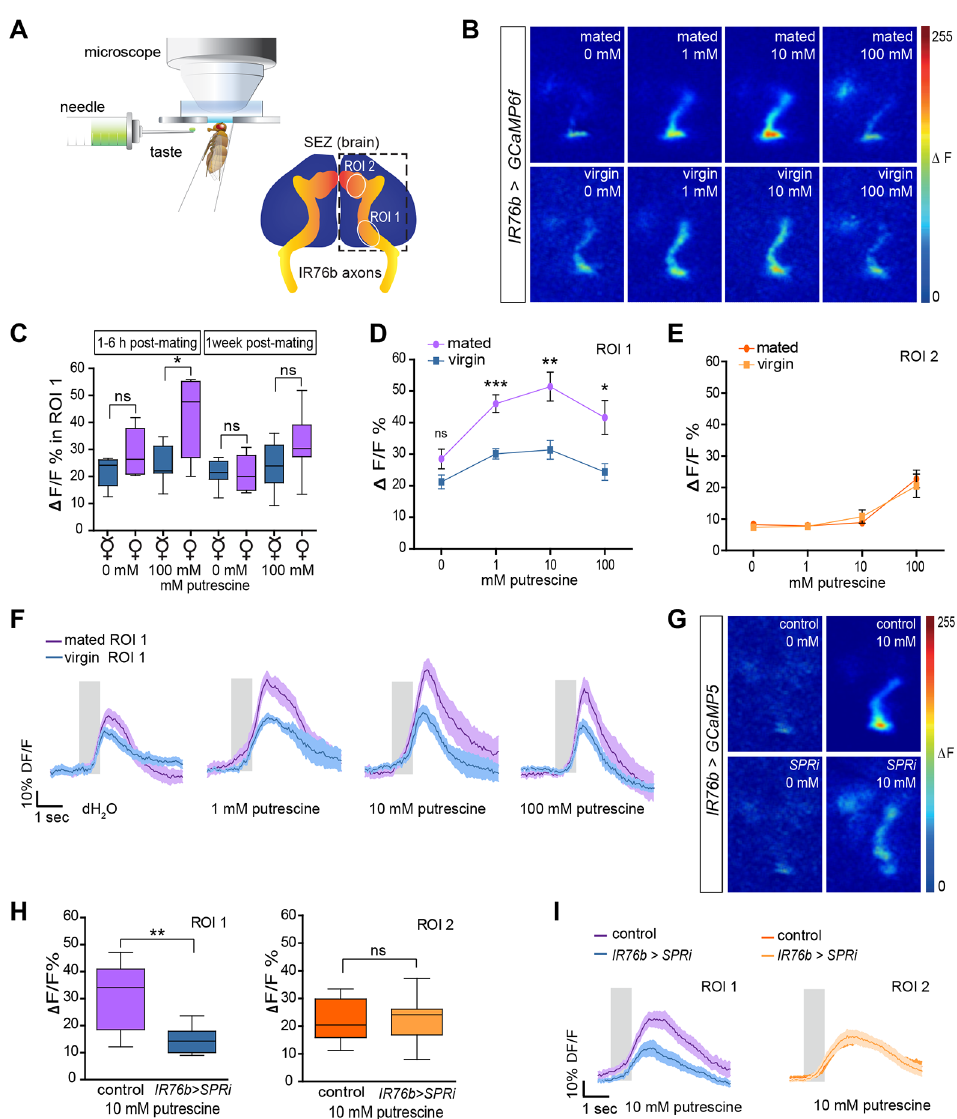
Fig 3. Mating increases sensitivity of taste neurons through SPR. (A) Scheme ofthe SEZ in vivo calcium imagingsetup (top). Illustration of theSEZ area showing the innervation pattern ofIR76b taste neuronaxons (bottom). ROI 1 and ROI 2 delineate theregions ofinterest (ROI) used for quantification ofthe relative change in GCaMP-fluorescence (% Δ F/F). (B) Representative images of SEZ imaging of IR76b-Gal4; UAS-GCaMP6f mated and virginfemaleflies stimulated with distilled water (0 mM), 1 mM putrescine (1 mM), 10 mM putrescine (10 mM), and 100 mM putrescine (100 mM), respectively. (C) IR76btaste neuron terminals of mated females show a significantly increased response to putrescineafter mating. While theresponse is highly significant at 1 – 6 h post- mating, it remains only a trend at 1 wk post-mating ( n = 7). (D) Females at 1 – 6 h post-mating showhigher IR76b taste neuronresponses. GCaMP6f-fluorescence peak responses were quantified (in% Δ F/F) in the ROI 1 area. Flies were stimulated with increasing concentrations of putrescine ( n = 7).(E) IR76btaste neurons of the same females as in(D) show no difference in the ROI 2 area. (F) Averageresponse trace of theROI 1 area ( n = 7). The gray bar illustrates the stimulation period. The dark colored linein themiddlepresents theaverage value, andthe light shade presents the SEM. (G) Representative images of IR76bGRN axons in theSEZ oftest ( IR76b-Gal4 , UAS-SPRi;UAS-GCaMP5 ) and control ( IR76b-Gal4;UAS-GCaMP5 ) females at 1 – 6 h post-mating.Flies were stimulated with distilled water (0 mM) and 10mM putrescine(10 mM). (H) Quantification of peak responses (in % Δ F/F) of IR76b axon terminals of IR76b-Gal4 , UAS-SPRi;UAS-GCaMP5 and control( IR76b-Gal4;UAS-GCaMP5 ) females at 1 – 6 h post-mating ( n = 8). Box plots show medianand upper/lower quartiles, and whiskers show minimum/maximum values. (I) Average response trace ofROI 1 andROI 2 area of IR76baxons in the SEZ of IR76b > SPRi and control females ( n = 8). All p -values were calculatedusingan unpaired t-test ( * p (cid:1) 0.05, ** p (cid:1) 0.01, *** p (cid:1)